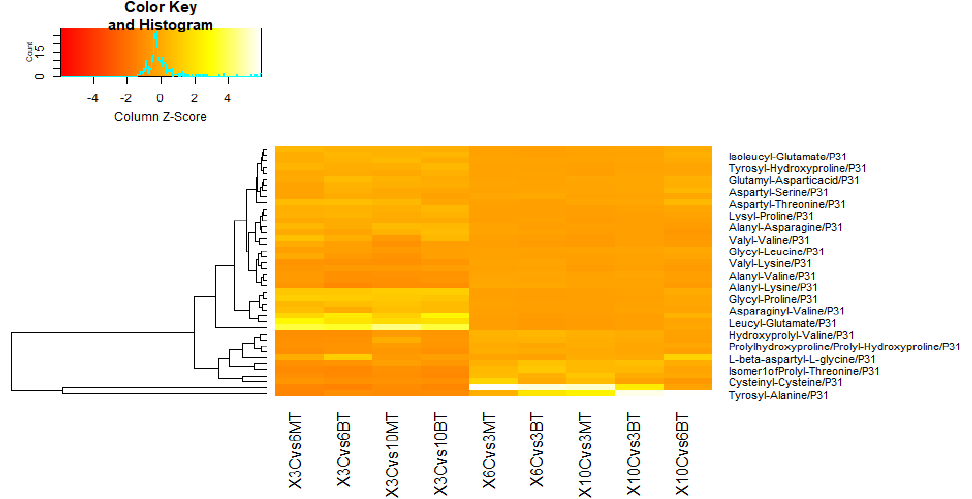
Figure 4. Heat map showing some of the differentially expressed metabolites of dipeptides and tripeptides pathway (P31) in different comparisons between positive control plants (C) and Metarhizium (MT) or Beauveria (BT) treatments at different Dpi. Z score is a measure of distance, in standard deviations, from the plate mean. A well with a Z score of 0 has the same raw value as the plate mean. A well with a Z score of 1.0 is exactly one standard deviation above the plate mean and a Z score of − 0.5 is half a standard deviation below the plate mean.